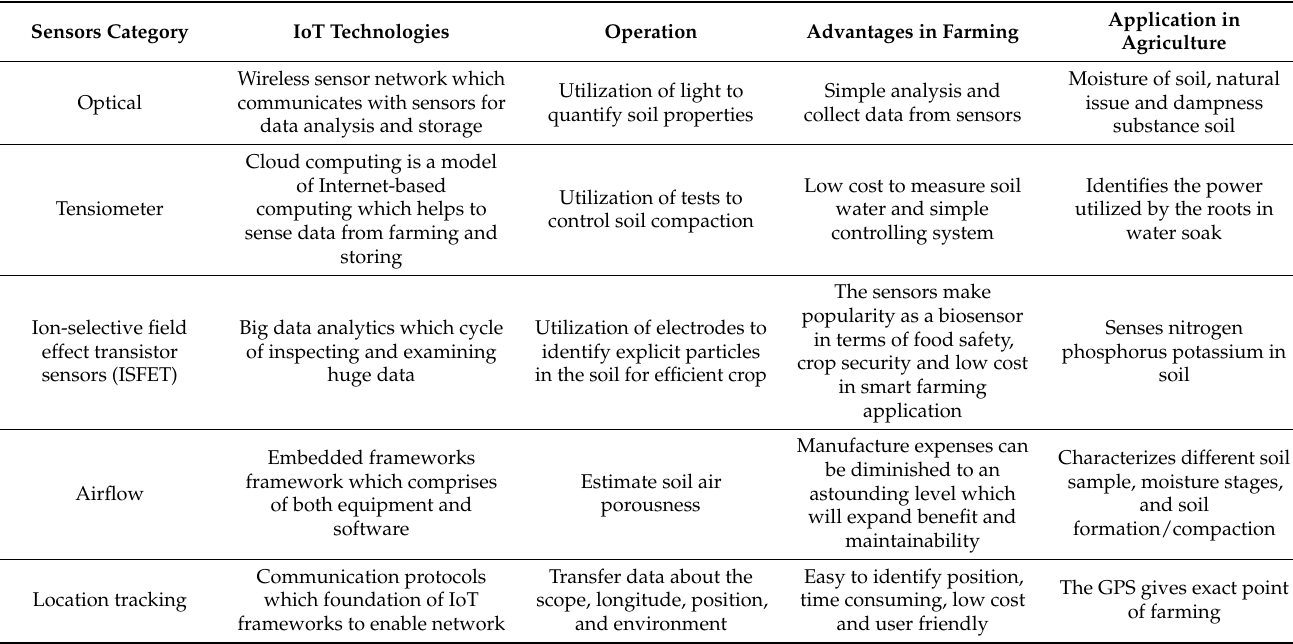
Table 3. IoT sensor categories utilized in smart